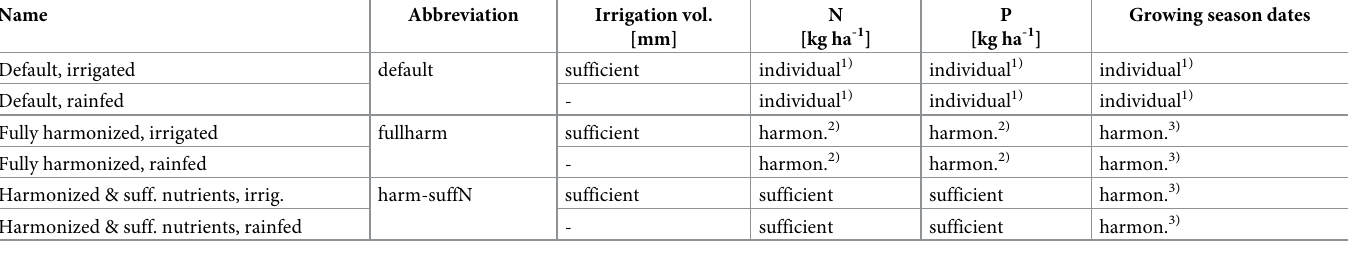
Table 1. Crop management scenarios based on Elliott et al. [34]. The default setup represents each modelling group’s own assumptions, input data and management parameters. The harmonized scenarios use the same growing season data [51] and the same annual application rates for N and P [52] (fullharm) or sufficient nutrient sup- ply (harm-suffN) to avoid nutrient-related plant growth limitations. See Fig E, panel a,b in S1 File for maps of harmonized N and P application